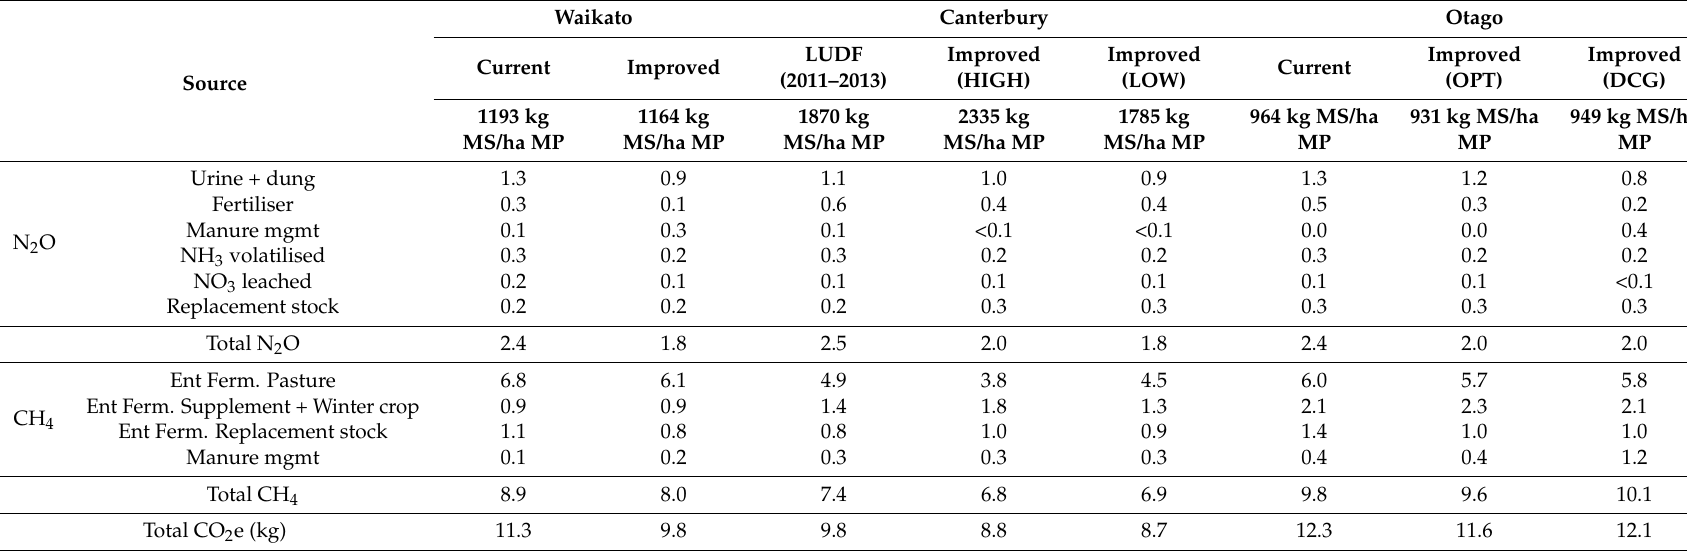
Table 4. Emissions intensity (kg carbon dioxide equivalents per milksolids (kg CO 2 e/kg MS)) calculated for nitrous oxide (N 2 O) and methane (CH 4 ) for current and improved farm systems tested on small-scale farms in three regions in New Zealand (Waikato, Canterbury, and Otago). HIGH and LOW = high and low stocking rate; OPT = optimised feeding and DCG = duration controlled grazing. See text for further descriptions of each systems. Note: may not sum to total due to